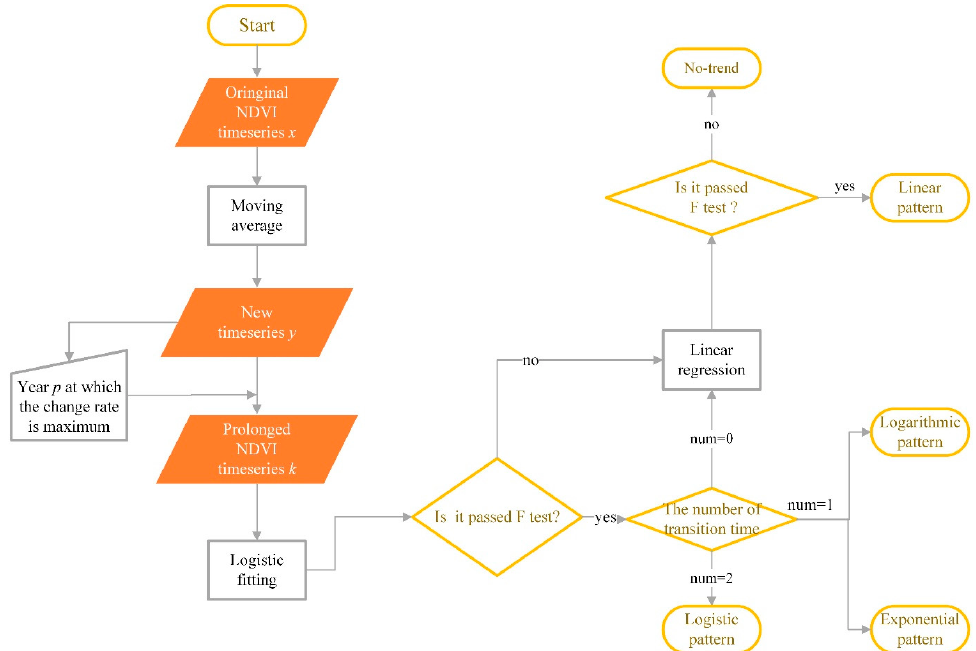
Figure 2. The flowchart of our framework. Patterns of the monotonous changes in vegetation are divided into four patterns. They are linear pattern, exponential pattern, logarithmic pattern and logistic pattern. All the hypotheses in the framework are tested at a 5% significance level.